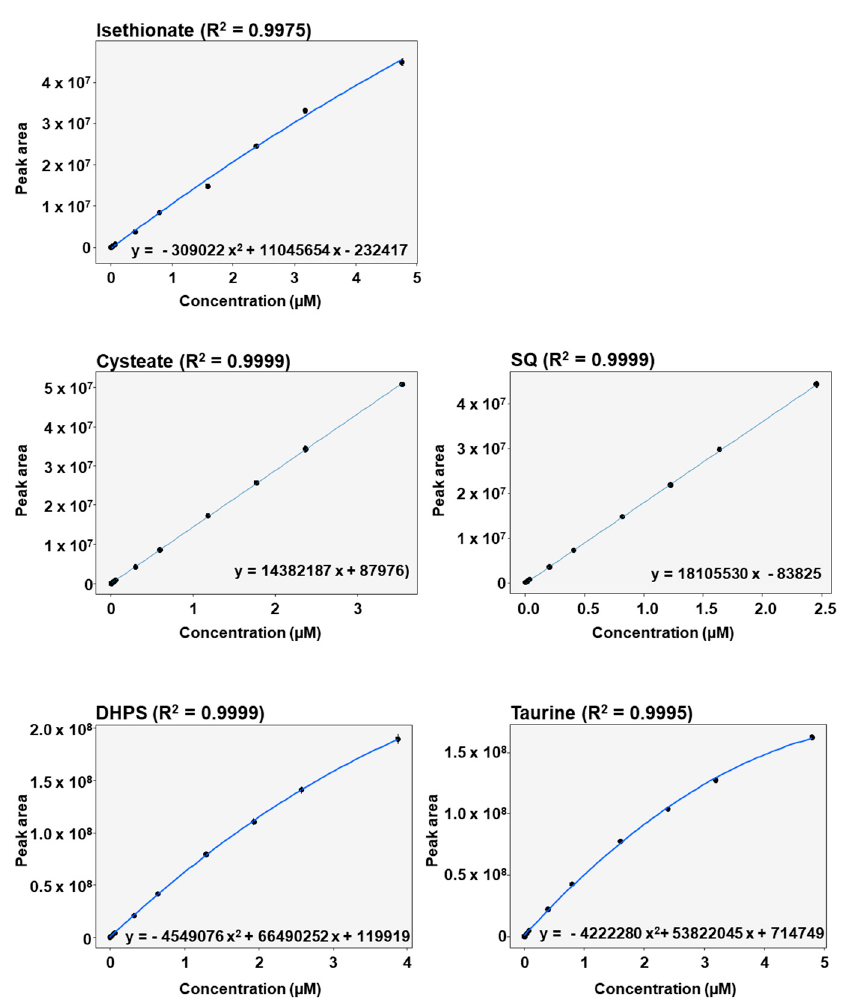
Figure 3. Calibration curves with regression equations and Pearson coe ffi cients of sulfonate standards spiked into fecal supernatants and diluted 1:10,000.